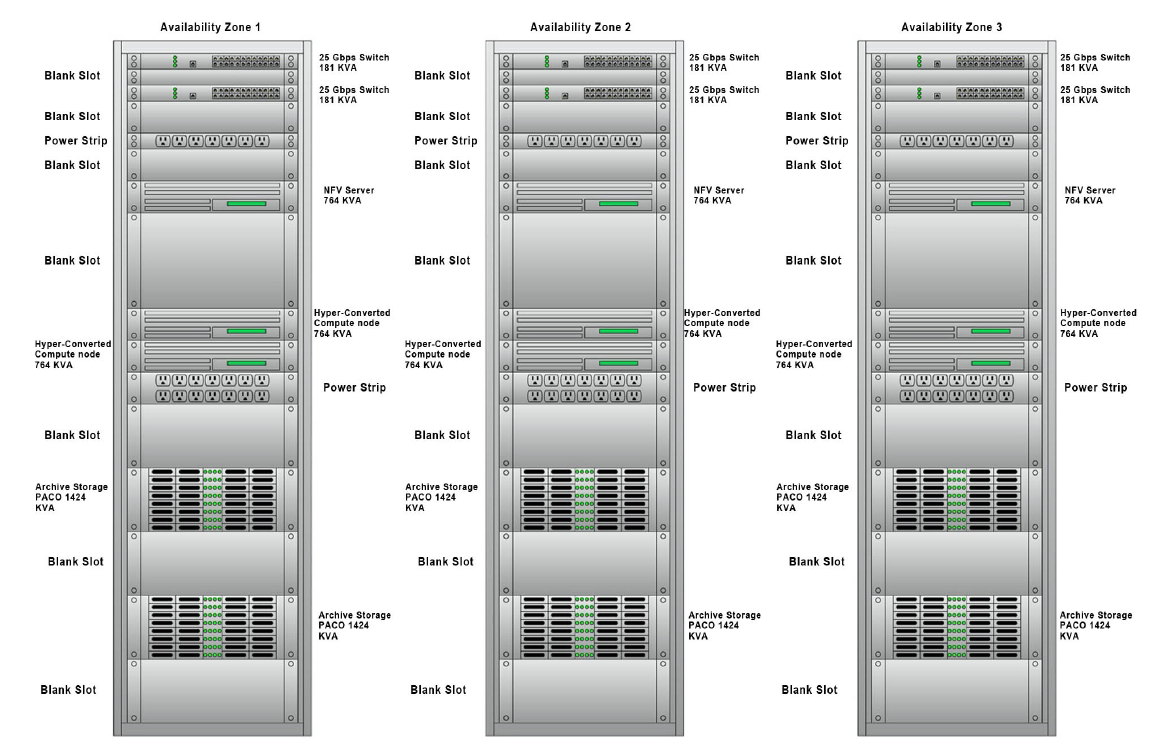
Figure 5. Phase 2 Space and Power Needs are Shown in the Rack